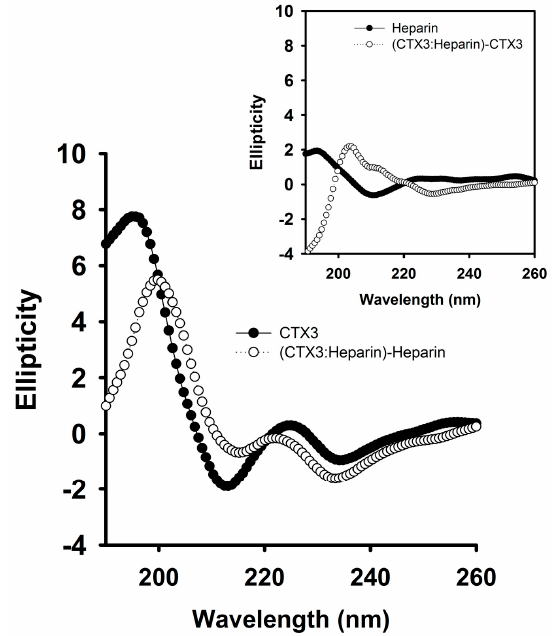
Figure 4. The CD spectra of CTX3 and CTX3-heparin complexes. As shown in Figure 3, the addition of 1.8 µ g/mL heparin notably detached CTX3 (300 nM) from aptamer. Thus, the CD spectra were measured at a CTX3 concentration of 300 µ M and a heparin concentration of 100 µ M (1800 µ g/mL, MW of heparin ~18,000) in 10 mM 4-(2-hydroxyethyl)piperazine-1-ethanesulfonic acid (HEPES) (pH 8.0). The CD spectrum of CTX3-heparin complexes was subtracted by that of heparin. (Inset) The CD spectrum of CTX3-heparin complexes was subtracted by that of CTX3.